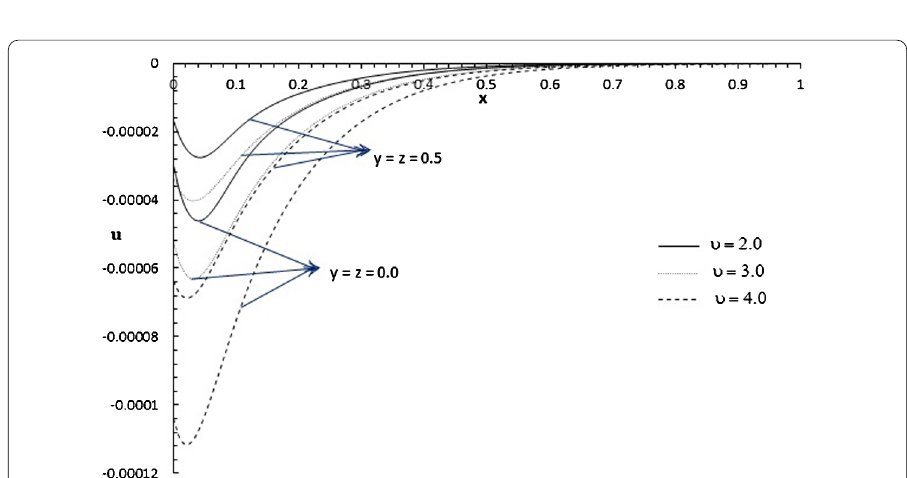
Figure 5 The displacement component u x distribution for various values of heat